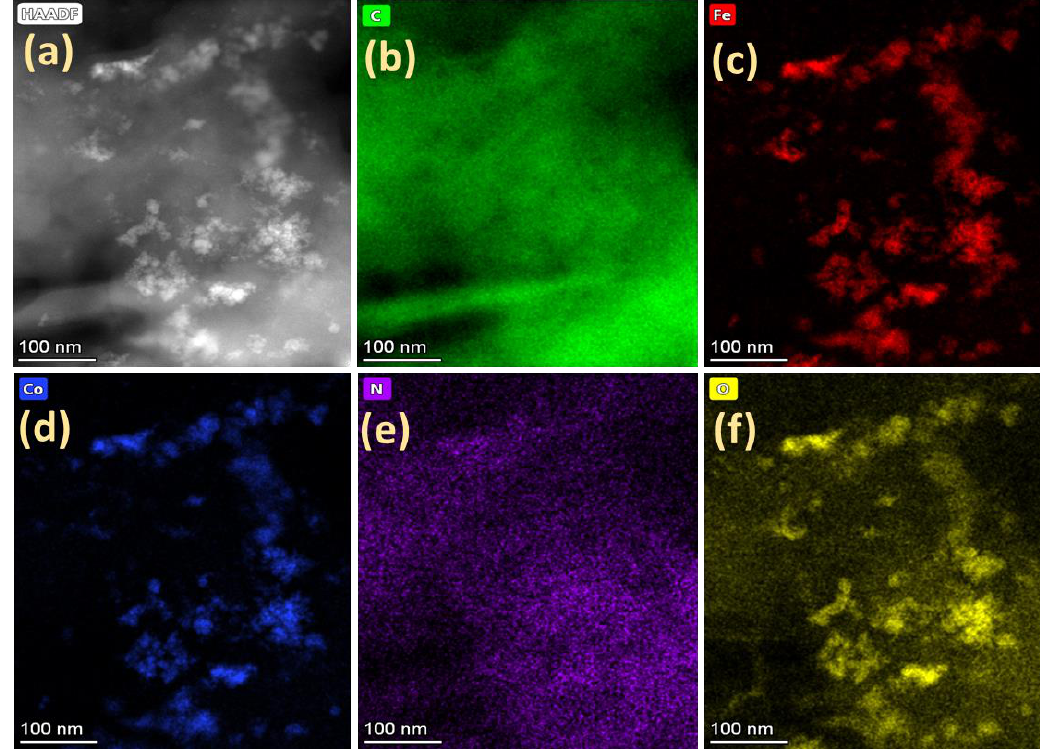
Figure 2. HAADF images of CoO x - Fe 3 O 4 /N - rGO ( a ). The corresponding STEM - EDS elemental maps of C ( b ), Fe ( c ), Co ( d ), N ( e ), and O ( f ). The XRD patterns of CoO x - Fe 3 O 4 /N - rGO and GO are shown in Figure 3a. The peaks at 2θ values of 26.3, 44.5, and 54.3° are typically assigned to the graphite (#04 - 014 - 0362) phase and correspond to reflection from (002), (101), and (004) planes. It is worth mentioning that the GO contained 4–10% edge - oxidized species; therefore, we did not observe the typical GO peak at ~10° [53]. The additional peaks at 2θ values of 30.6, 36.1, 58.2, and 68.3° observed with CoO x - Fe 3 O 4 /N - rGO are assigned to Co 3 O 4 [35] and Fe 3 O 4 [67] phases, respectively. The Raman spectra of both samples shown in Figure 3b show D, G, and 2D peaks. The D (1344 cm −1 ) and G (1570 cm −1 ) peaks are associated with the A 1g breathing vibration of hexagonal sp 2 carbon rings and E 2g vibrations of sp 2 carbon bonds. The 2D (2685 cm −1 ) peak is a second - order vibration of the D peak [68]. The additional peaks at 1983 and 2940 cm −1 (D+D’) could be observed with CoO x - Fe 3 O 4 /N - rGO. The broad Raman band at 1983 cm −1 may have been associated with the fluorescence signal [69] of the CoO x - Fe 3 O 4 /N - rGO after doping. The I D /I G ratios of 0.38 and 0.33 were for GO and CoO x - Fe 3 O 4 /N - rGO, respectively, suggesting that defects were not introduced after doping and the structure was preserved, signifying decoration. The N 2 - physisorption results for CoO x - Fe 3 O 4 /N - rGO are shown in Figure 3c,d, highlighting the isotherm, differential pore size distribution, and cumulative volume, respectively. CoO x - Fe 3 O 4 /N - rGO mainly exhibited micropores with a BET surface area of 338.90 m 2 g −1 , 1.46 times higher than the graphene oxide (GO). The numbers of graphene layers in the edge - oxidized GO and CoO x - Fe 3 O 4 /N - rGO were estimated to be 11 and 8, respectively, with a d - spacing of 0.34 nm, suggesting multilayers, as seen from the TEM images (Figure 1).